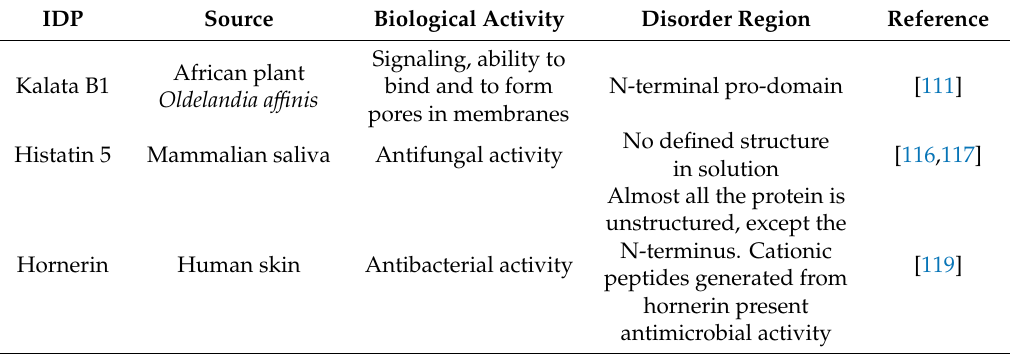
Table 3. Other intrinsically disordered proteins with biological